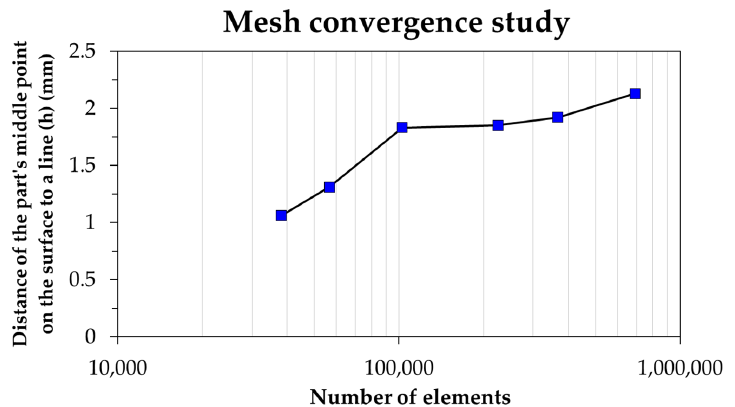
Figure 7. Mesh convergence study.